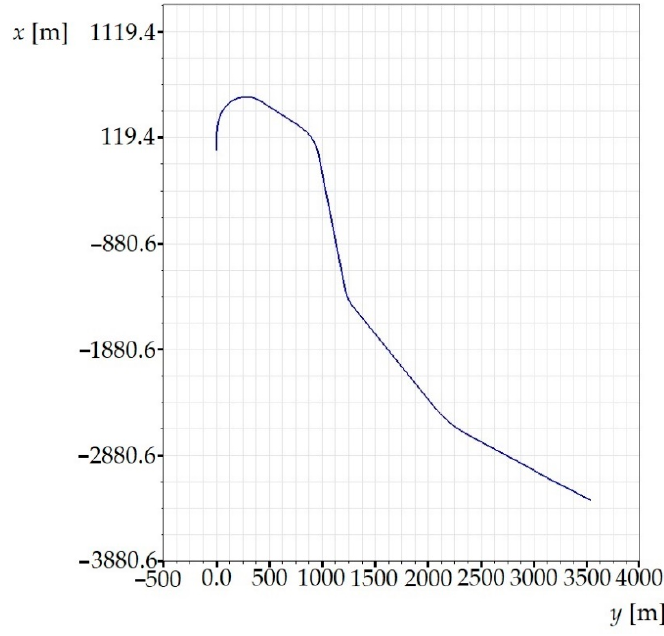
Figure 8. An illustration of the created railway track.